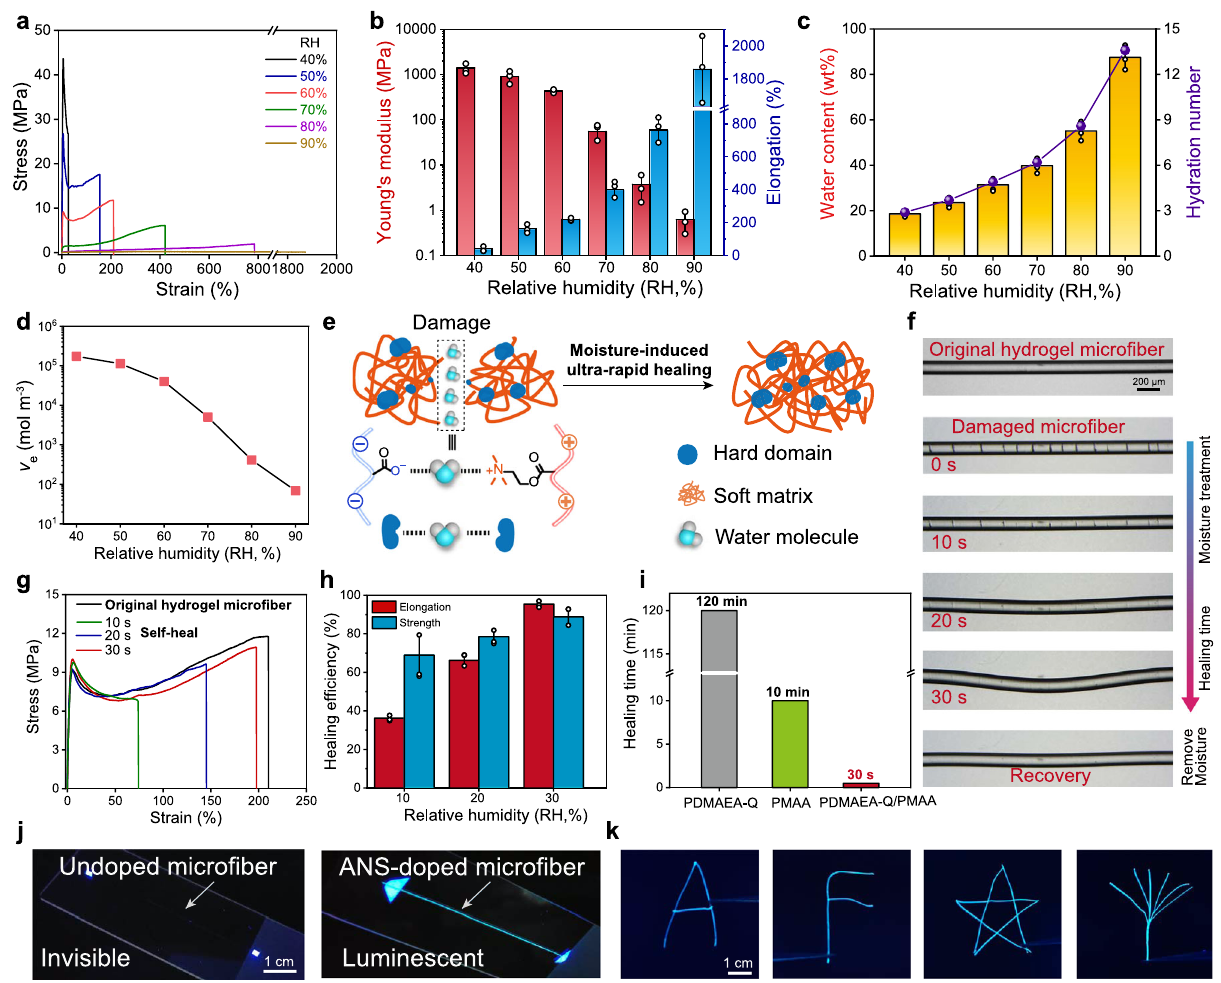
Fig. 4 | Moisture sensitivity and self-healability of PDMAEA-Q/PMAA hydrogel micro fi ber. a Tensile stress-strain curves at different humidities. b Corresponding Young ′ s moduli and elongations. c , d Humidity-dependent equilibrium water contents, hydration numbers, and effective crosslinking densities. e Schematic mechanism for moisture-induced ultra-rapid self-healing of the hydrogel micro- fi ber which relies on the chain diffusion and reformation of both ionic complexa- tions and H-bond clusters. f Optical images of moisture-induced rapid self-healing of multiple cracks on the micro fi ber. g Tensile curves of self-healed hydrogel